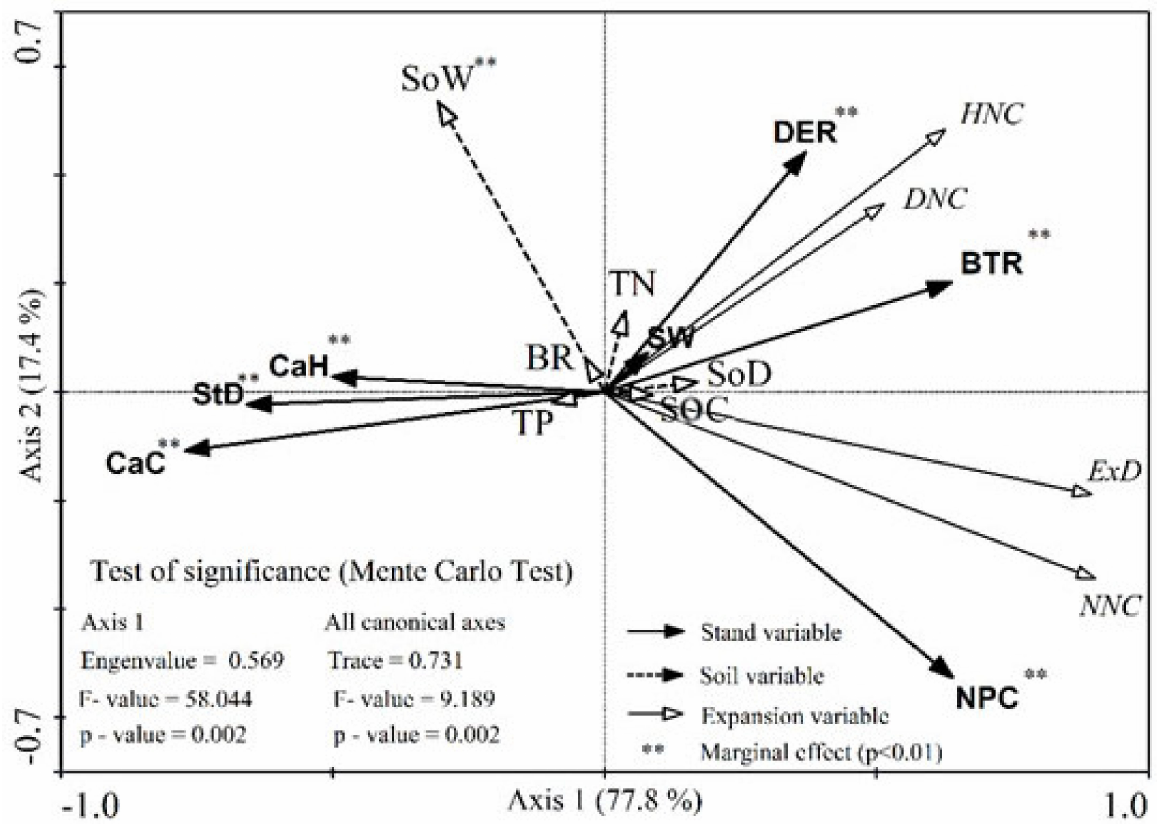
Figure 3. RDA biplot of fifty − eight samples, four bamboo expansion variables and thirteen environ- mental variables (seven stand variables and six soil variables) measured at each bamboo–woodland interface based on the first two axes. Arrows indicate the strength and direction of the relationship between each variable and each axis. Relationship with the axis increases with the length of the arrow and decreases with the angle respect to the axis. Relationships between variables can be inferred from the angle between arrows (maximum for parallel arrows and minimum for perpendicular arrows). The variables of bamboo expansion (hollow black arrows) included ExD (mean expansion distance, m), NNC (number of new culms, ind/100 m 2 ), DNC (diameter of new culms at 1.3 m, cm) and HNC (height of new culms, m). Stand variables (solid black arrow) included NPC (number of parent culms, –), CaC (canopy closure, –), CaH (canopy height, m), BTR (height ratio of moso bamboo to trees, –), DER (number ratio of deciduous trees to evergreen trees, –), StD (stand point density, ind/100 m 2 ) and SW (Shannon–Wiener index, bit). Soil variables (dotted black arrow) included SoD (soil depth, cm), SoW (soil water content, %), BR (bare-rock ratio, %), SOC (soil organic carbon content, %), TN (total nitrogen content, %) and TP (total phosphorus content,